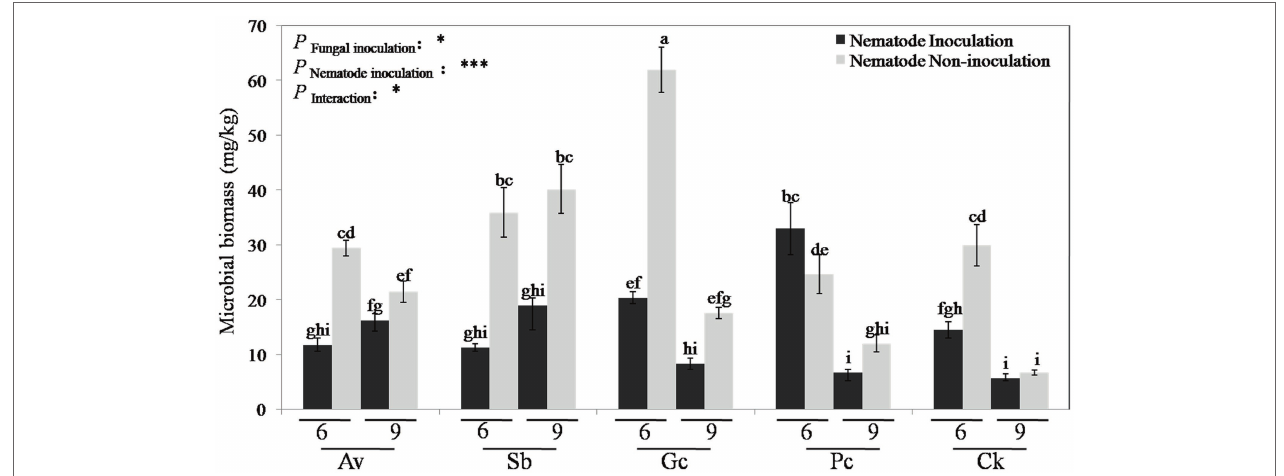
FIGURE 2 | Rhizosphere soil microbial biomass carbon of different treatments. Av, Sb, Gc, and Pc mean pine seedlings inoculated with A. vaginata , Suillus bovinus , G. cylindrosporus , and P. chrysanthemicola , CK as control group. Six and nine mean seedling 6 and 9 months after nematode inoculation. The data are means ± SD ( n = 3). Different lowercase letters indicate significant differences at p < 0.05, * p < 0.05; and *** p <